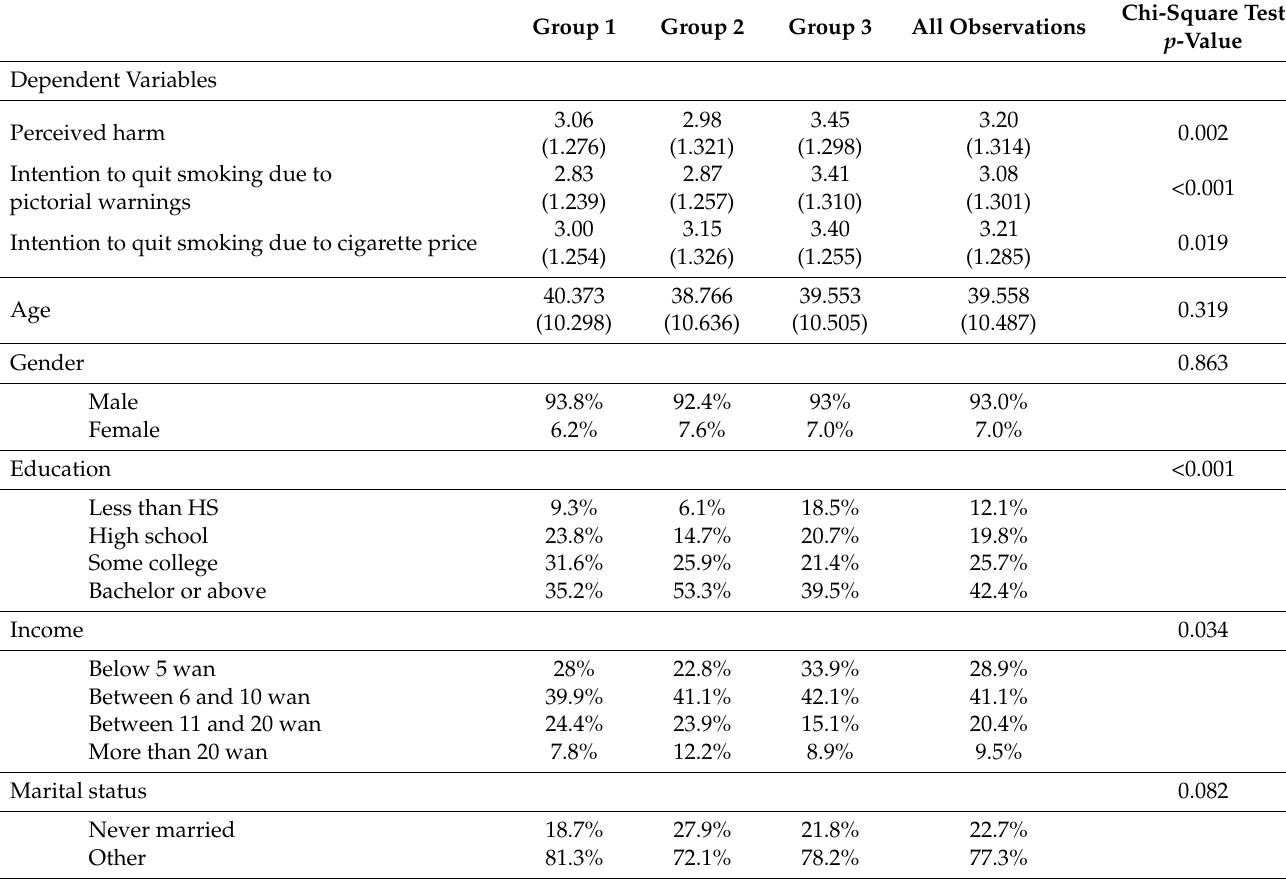
Table 1. Descriptive